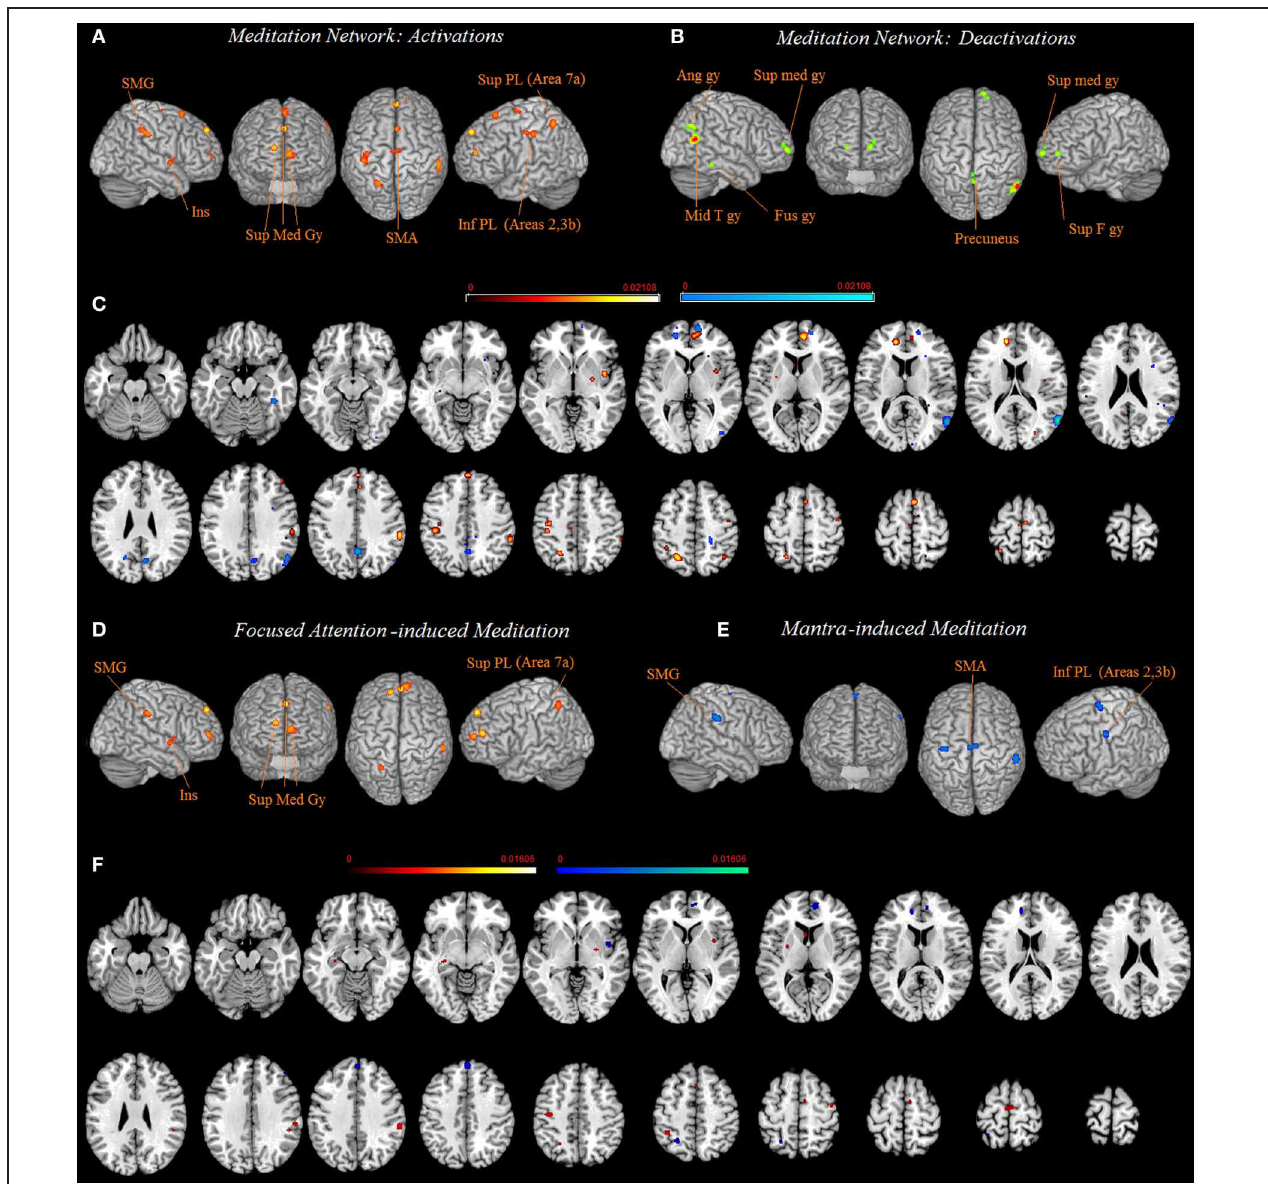
FIGURE 1 | Common network of activations (A) and deactivations (B) underlying meditation are displayed on a rendered template brain provided by spm5 and on axial slices of the MNI single subject template, with activations (in orange) and deactivations (in blue) overlaid on the same template (C). Relative increases in neural activity associated with meditation induced trough focused attention (D) and through mantra